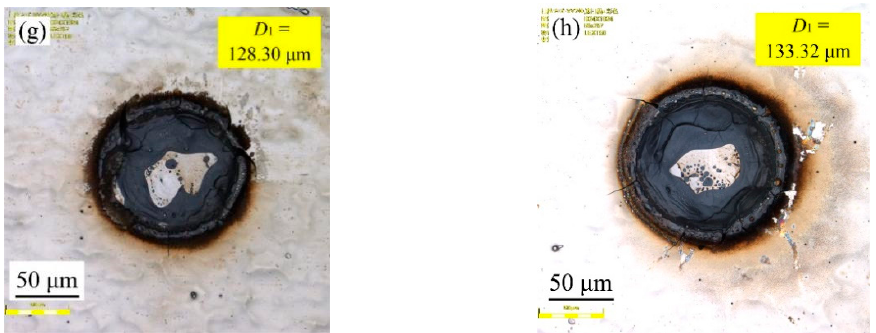
Figure 4. Effect of varying laser output power on samples’ surface morphologies: ( a ) 50 W; ( b ) 60 W; ( c ) 70 W; ( d ) 80 W; ( e ) 90 W; ( f ) 100 W; ( g ) 110 W; ( h ) 120 W.